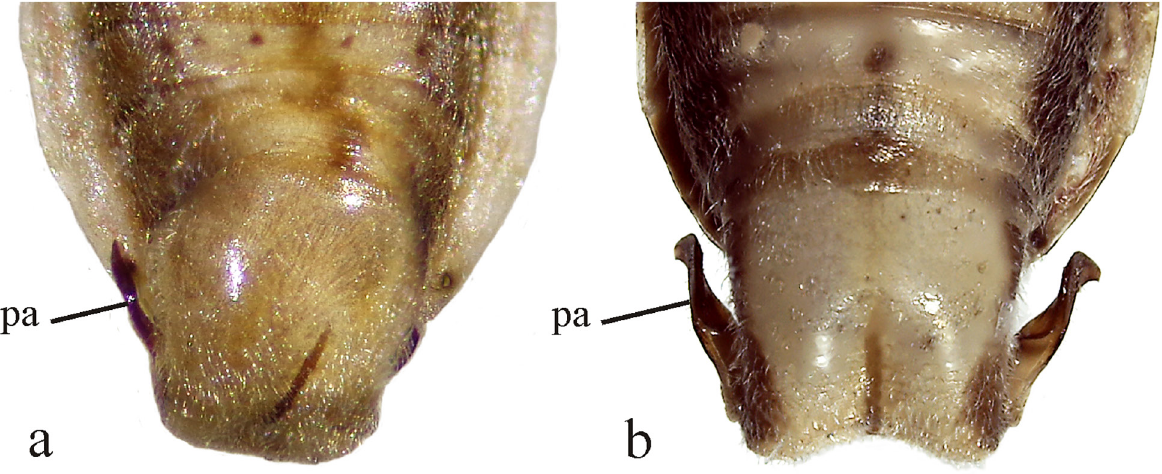
Figure 3. Male genital capsule. a, Nabis ( Austronabis ) argentinus. b, N . ( Dolichonabis ) ashworthi. (pa: